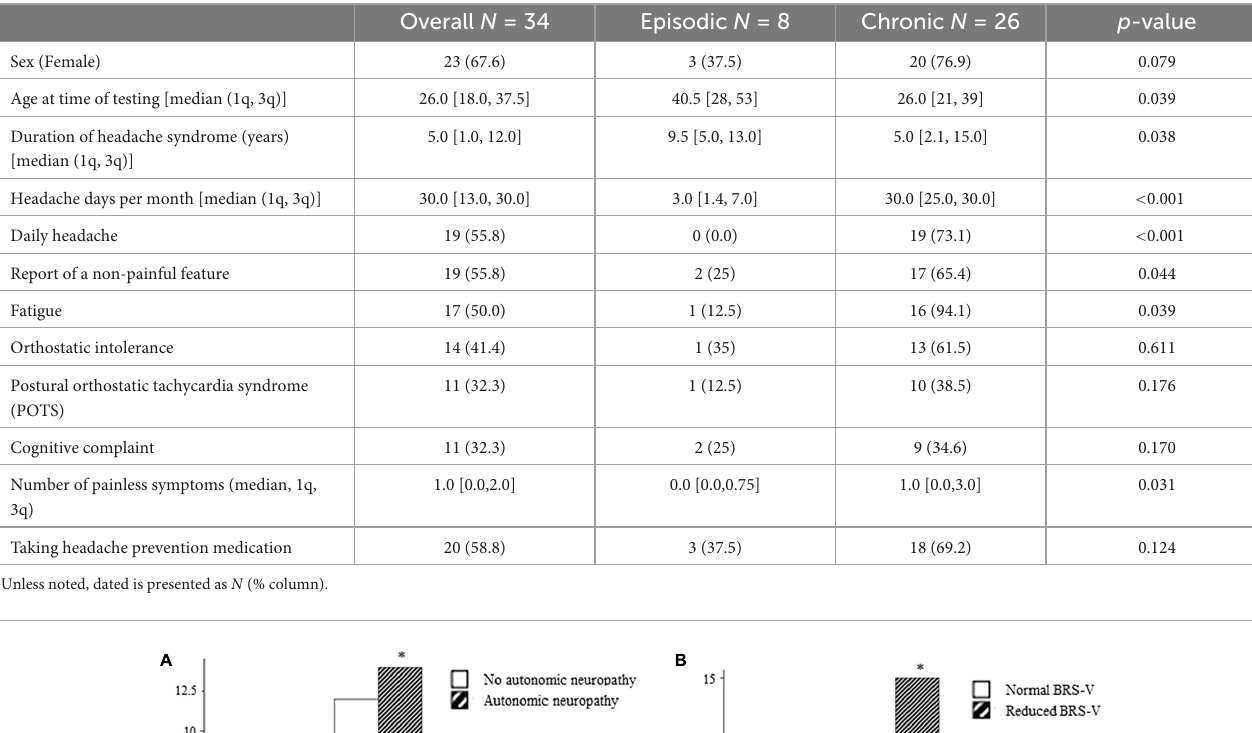
TABLE 1 Patient characteristics*.